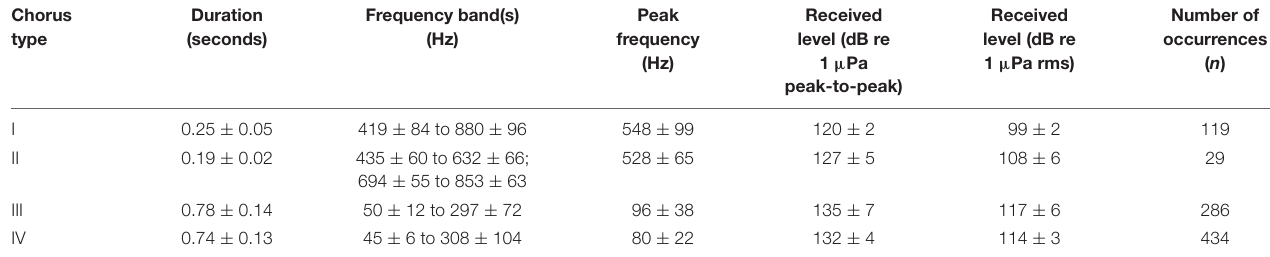
TABLE 2 | Frequency and temporal characteristics (mean ± standard deviation) of the individual calls of four distinct fish